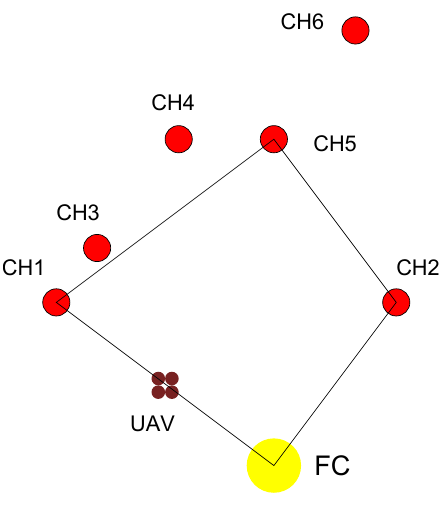
Figure A2. The whole multi-robot system consists of a fusion center (FC) where the UAV starts its route and 6 cluster of robots around FC. The red circles show the locations of the cluster head (CH) robots in their robot cluster. The UAV uses the strategy π 2 for the data collection . With respect to this initial position of the UAV at ξ 0 = ( 0,0 ) , the positions of the Ch robots are ( ξ 1 , ξ 2 , ξ 3 , ξ 4 , ξ 5 , ξ 6 ) = (( − 16,12 ) , ( 9,16 ) , ( − 13,16 ) , ( − 7,24 ) , ( 0,24 ) , ( 6,32 ))